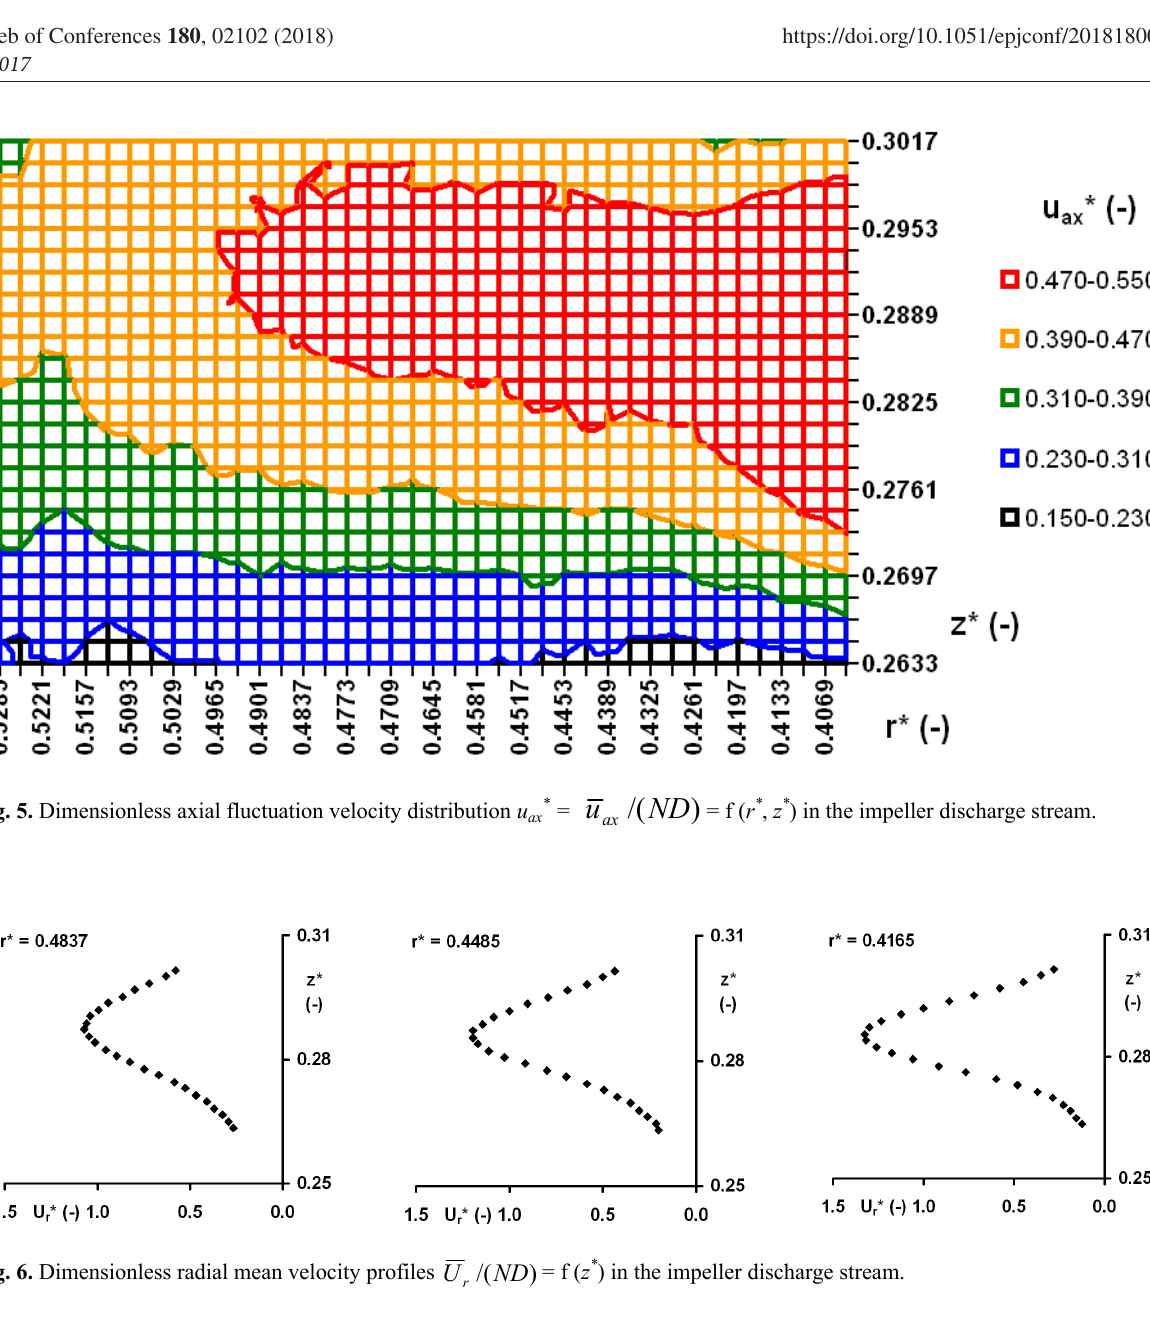
= f ( z * ) in the impeller discharge stream. r